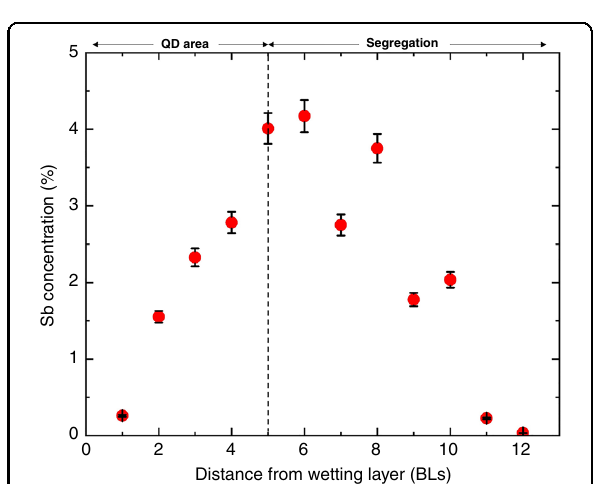
Fig. 9 Sb concentration as a function of distance in BLs from the wetting layer in the growth direction [001]. The distance from 0 to the dotted line along the x -axis represents the area occupied by the QDs, the dotted line being the top of the QDs. The Sb atoms are counted over a distance of 1 μ m on each atomic row, using multiple X-STM fi lled-state images